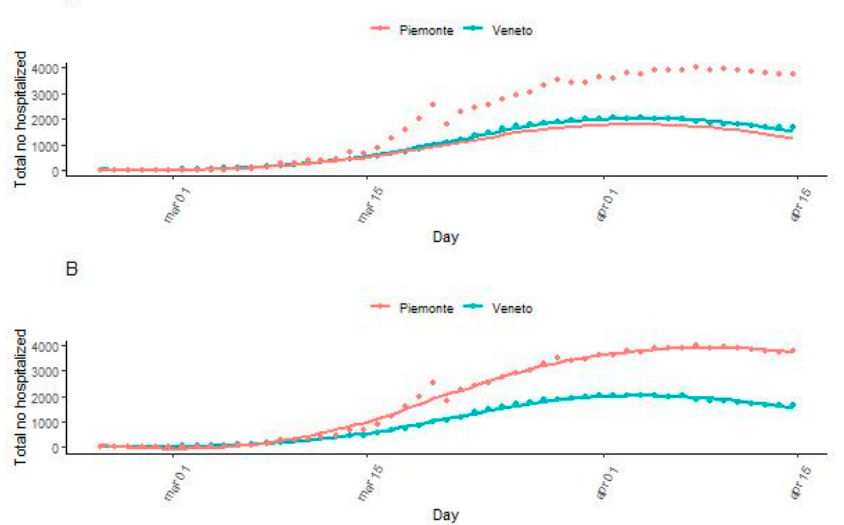
Figure 1. ( A ): Predicted trend of Covid-19 hospitalizations in Piemonte (red solid line) based on Veneto daily cumulative number of Covid-19 positive cases. Observed hospitalizations are reported as red points in Piemonte and blue points in Veneto; ( B ): predicted trend of hospitalizations in Piemonte (red solid line) based on daily cumulative number of Covid-19 positive cases in Veneto and the number of swabs performed.